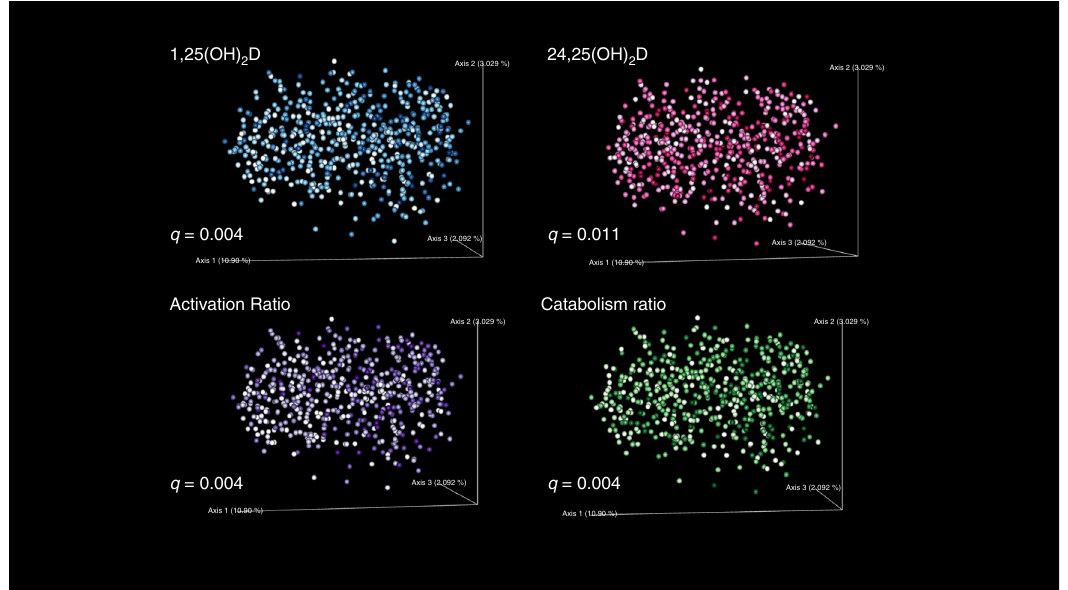
Fig. 5 Vitamin D metabolites correlate with clusters in β -diversity distribution. Vitamin D activation ratio ( q = 0.004), and the vitamin D catabolism ratio ( q = 0.004) separated subjects into statistically signi fi cant clusters within the β -diversity distribution Unweighted UniFrac β -diversity PCoA plots of vitamin D metabolites. β -diversity is signi fi cantly strati fi ed according to 1,25(OH) 2 D, 24,25(OH) 2 D, vitamin D activation ratio, and vitamin D catabolism ratio based on PERMANOVA test after BH-FDR correction. Darker colors correspond to higher metabolite values. Source data are provided as Source data fi le: “ sourcedata_ fi g4b_ fi g5.txt ” remarkably associated with microbial β -diversity in unweighted from the Firmicutes and one from the Lentisphaerae phylum, UniFrac and PERMANOVA testing. with all of the Firmicutes being further classi fi ed into the Clos- tridia class and Clostridiales order. Beyond that, two were from Ruminococcaceae family, one of which was identi fi ed to the Vitamin D metabolites and speci fi c taxonomies . In random Oscillospira genus. The remaining Firmicutes sOTUs were from forest analyses with 5-fold cross-validation of bacterial gene the Lachnospiraceae and Victivallaceae family and Mogibacter- sequences, 12 unique stool sub-Operational Taxonomic Units ium genus. The only sOTU from the Lentisphaerae phylum (sOTUs) were identi fi ed to correlate with vitamin D metabolism belonged to the family Victivallaceae. For all but three sOTUs, the (Table 2). Six sOTUs were associated with 1,25(OH) 2 D, of which Firmicutes phylum was positively associated with higher levels of all were from the Firmicutes phlyum, Clostridia class, and Clos- 1,25(OH) 2 D and the ratio of activation, while the direction of the tridia order and recognized to be producers of butyrate. Of the association was negative in the Oscillospira, Blautia , and Anae- eight sOTUs identi fi ed with the ratio of activation, seven were rotruncus genus (Table 2).